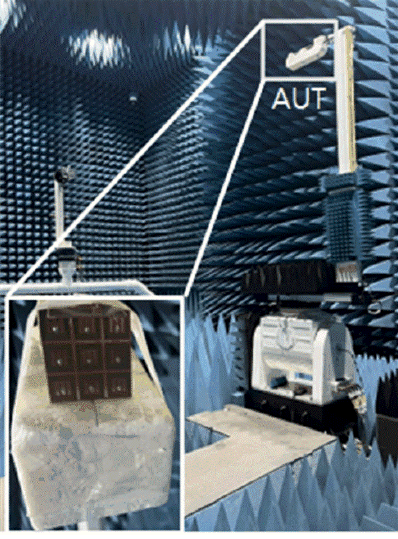
Figure 3. Photographs of the test setup in an anechoic chamber for far-field measurements.